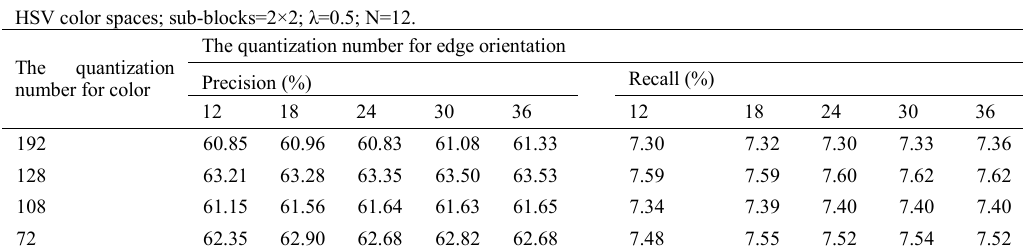
Table 2. Average retrieval precision and recall in the HSV color space